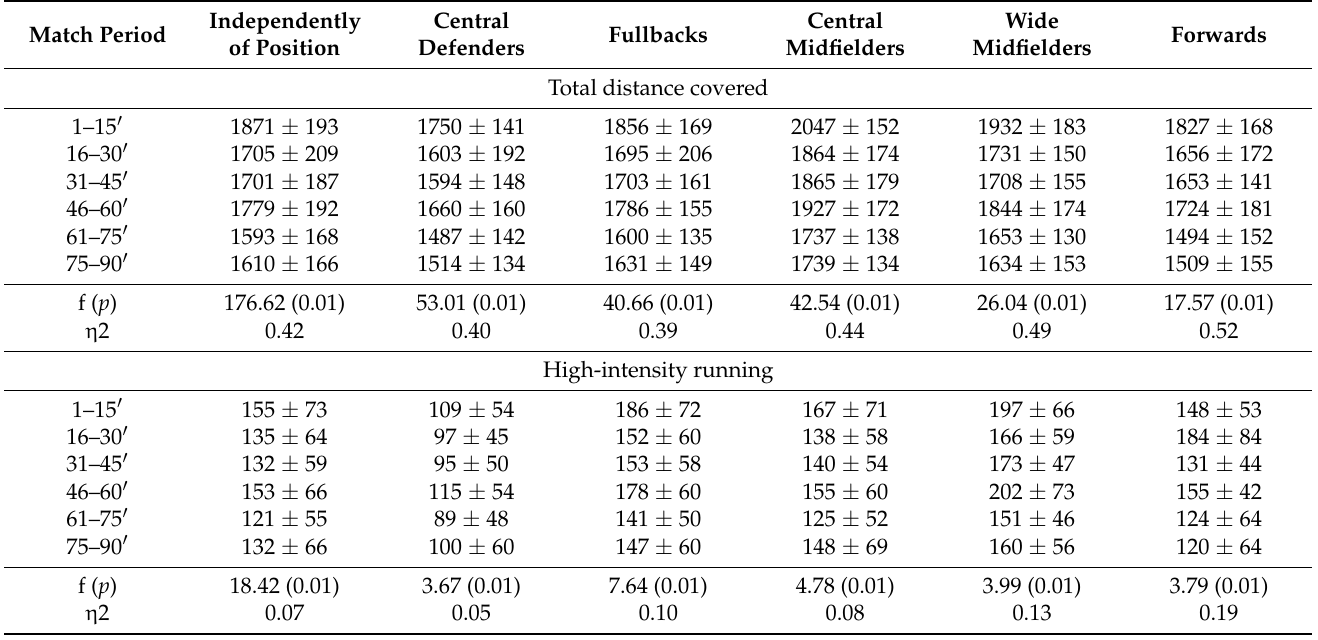
Table 2. Descriptive statistics and differences in total distance covered and high-intensity running among 15-min match periods (data are given as mean ± SD).